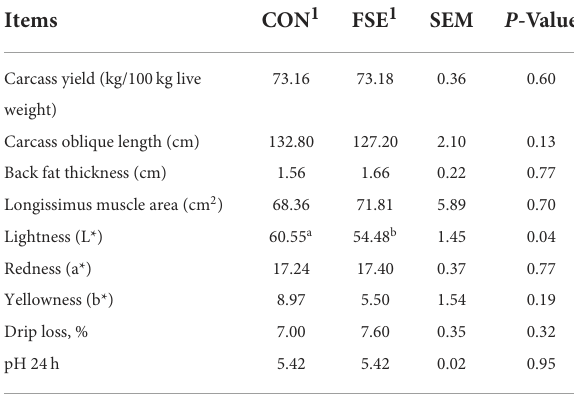
TABLE 3 Effect of Forsythia suspensa extract on the meat quality of finishing